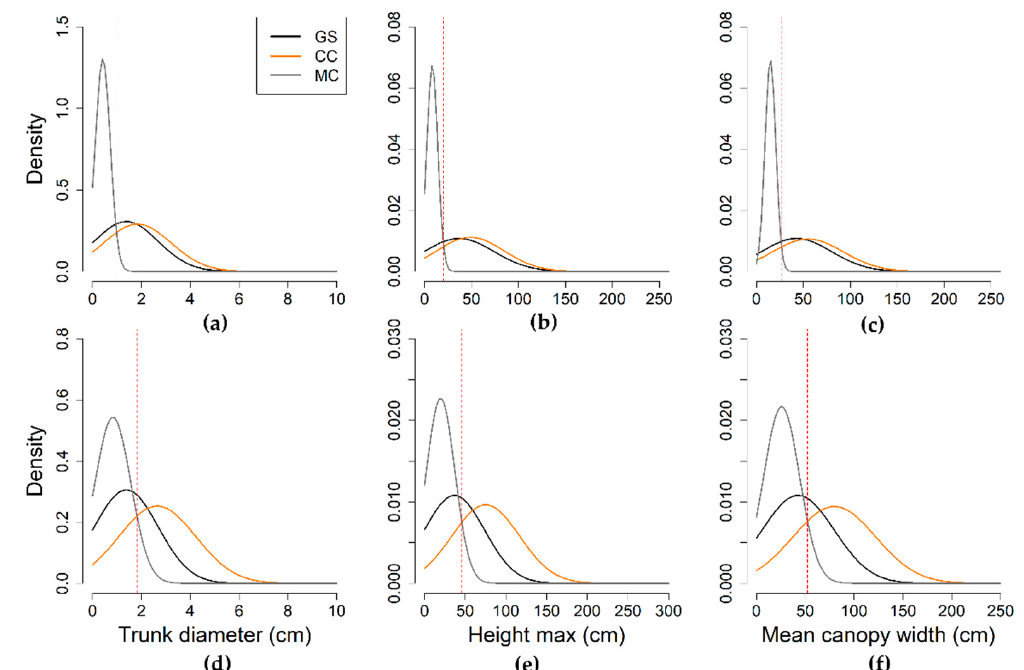
Figure 8. Density curve of the trunk diameter ( a , d ), maximum height ( b , e ) and mean canopy width ( c , f ) of the ground- surveyed larches (GS; solid black line), larches correctly classified (CC; solid orange line) and larches that were not detected and so misclassified (MC; solid grey line) through the photo-interpretation. Density plots are reported for both low- resolution ( a – c ) and high-resolution ( d – f ) images acquired by drone in an abandoned subalpine grassland during mid- October 2018. The dashed red line marks the intersection between CC- and MC-larches density curves, whose x -value was set as the size threshold of photo-interpretation efficiency.